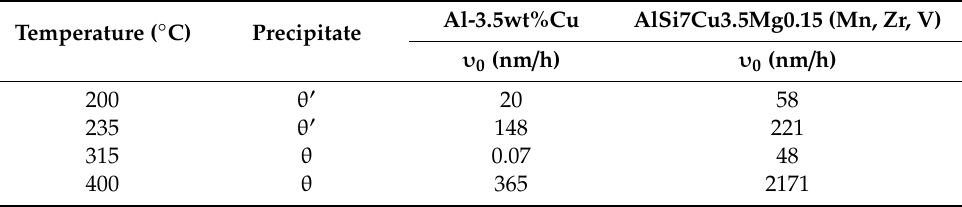
Table 6. Estimation of the initial growth velocity υ 0 of θ (cid:48) and θ precipitates at di ff erent temperatures in two alloys containing 3.5